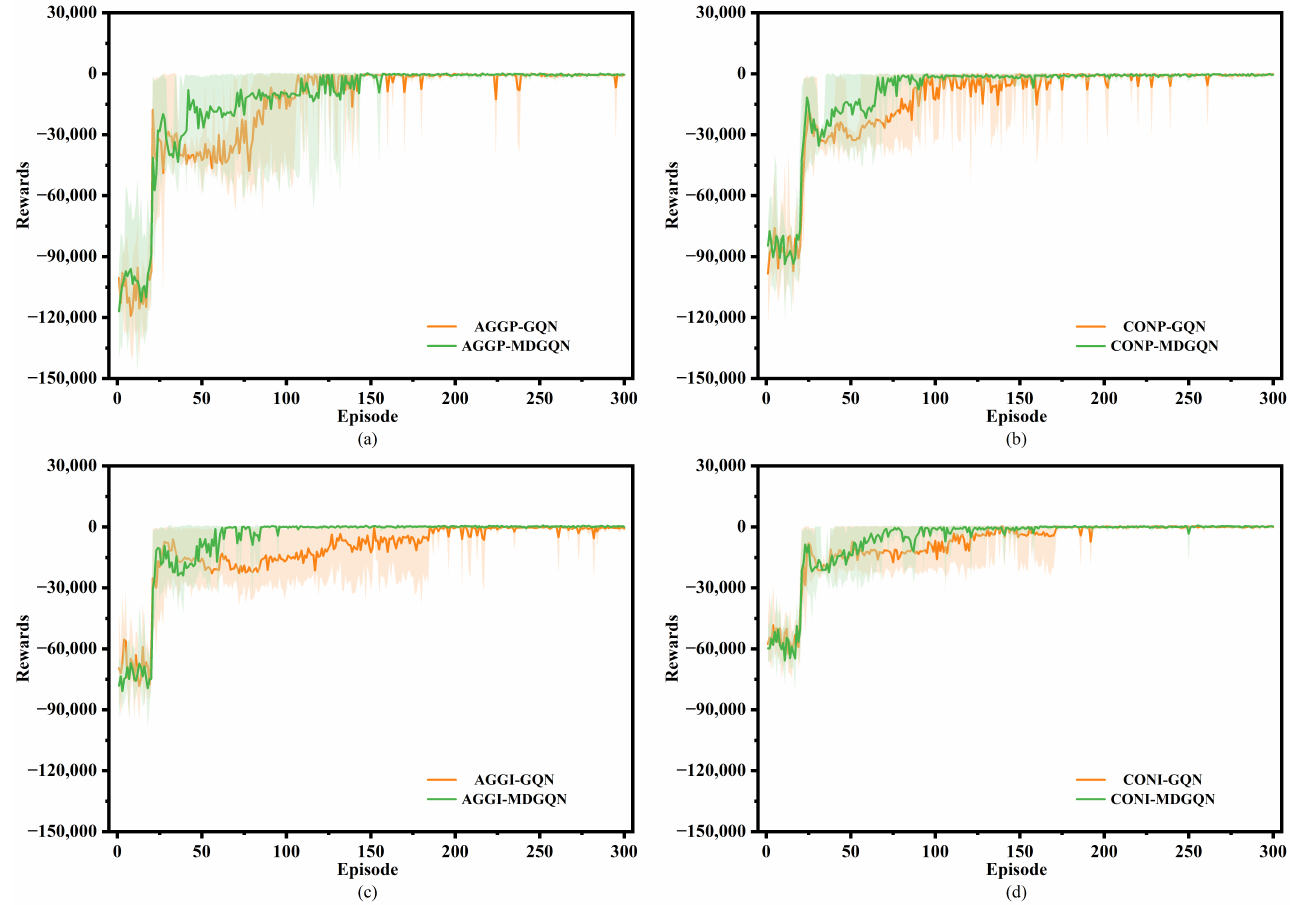
Figure 5. The training reward diagrams of four modes are compared and verified by the GQN and MDGQN algorithms. ( a ) The AGGP decision-making mode, ( b ) the CONP decision-making mode, ( c ) the AGGI decision-making mode, and ( d ) the CONI decision-making